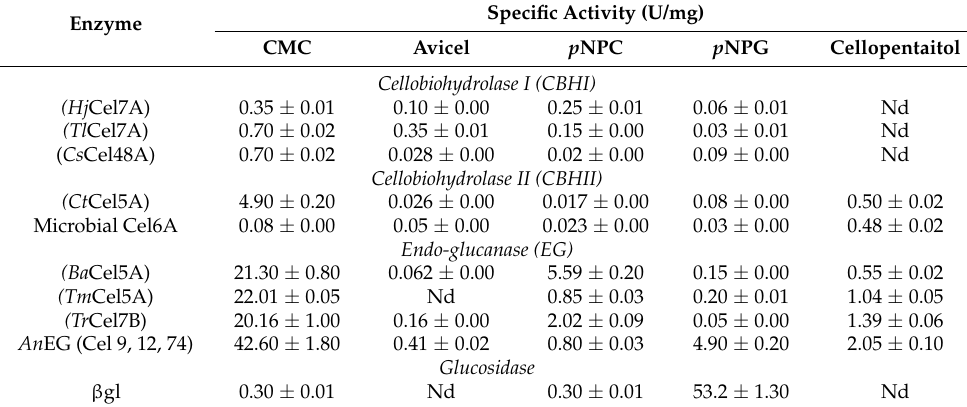
Table 1. Specific activities of cellulolytic enzymes on various cellulosic substrates. Specific Activity (U/mg) Enzyme CMC Avicel p NPC p NPG